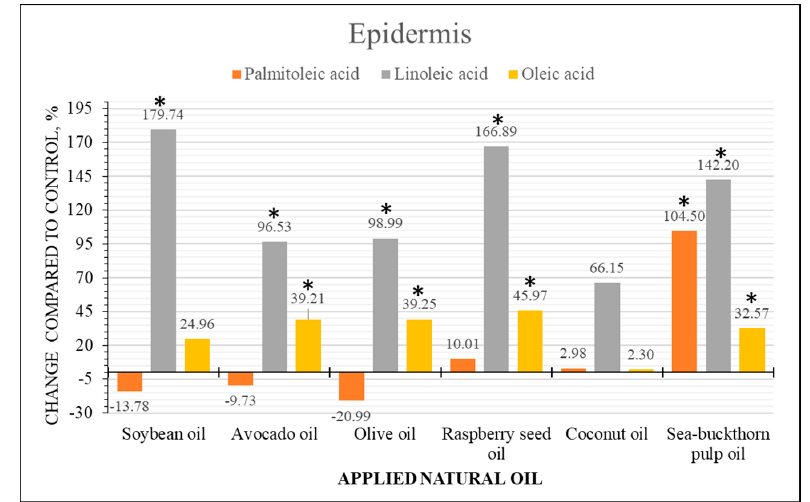
Figure 6. Comparison of FAs content changes in epidermis of human skin ex vivo samples treated with natural oils. The bars represent the percentile changes of intensities detected in the epidermis of natural oils treated samples and compared to the control. Statistically significant changes are marked * p < 0.05.